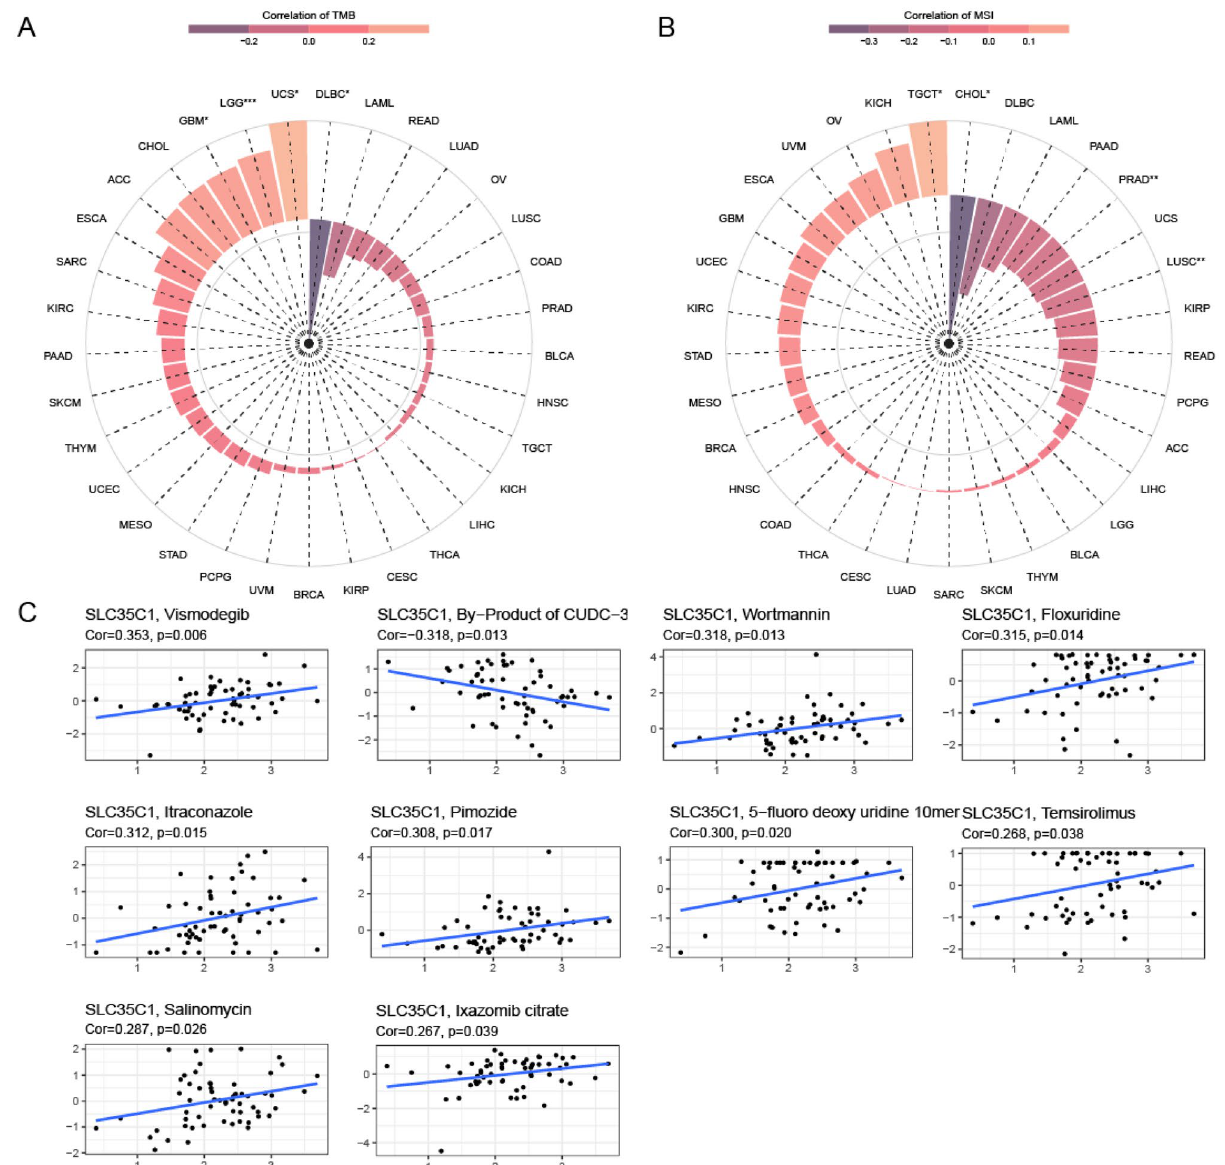
Figure 8. SLC35C1 expression is correlated with TMB, MSI and drug sensitivity. ( A ) Correlation analysis between SLC35C1 expression in pan-cancer and TMB described using Spearman’s rank correlation coefficient. ( B ) Correlation analysis between SLC35C1 expression in pan-cancer and MSI described using Spearman’s rank correlation coefficient. ( C ) Analysis of drug sensitivity associated with SLC35C1. The positive correlation means that the gene’s high expression is resistant to the drug, while the negative is the opposite. *P < 0.05; **P < 0.01; ***P <